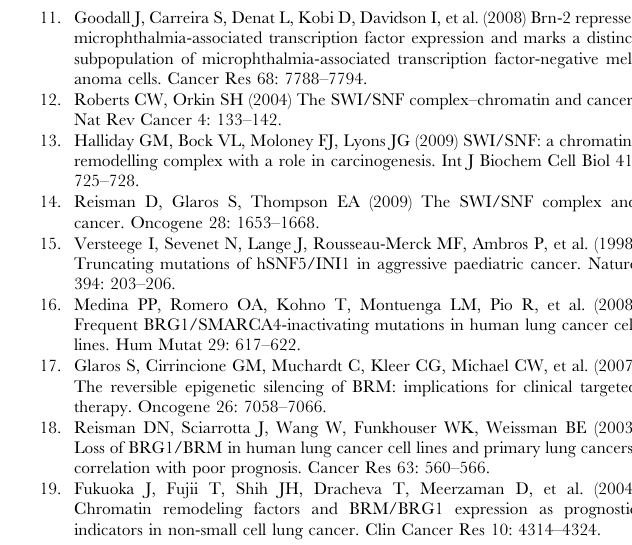
Table S3 Microarray analysis of genes